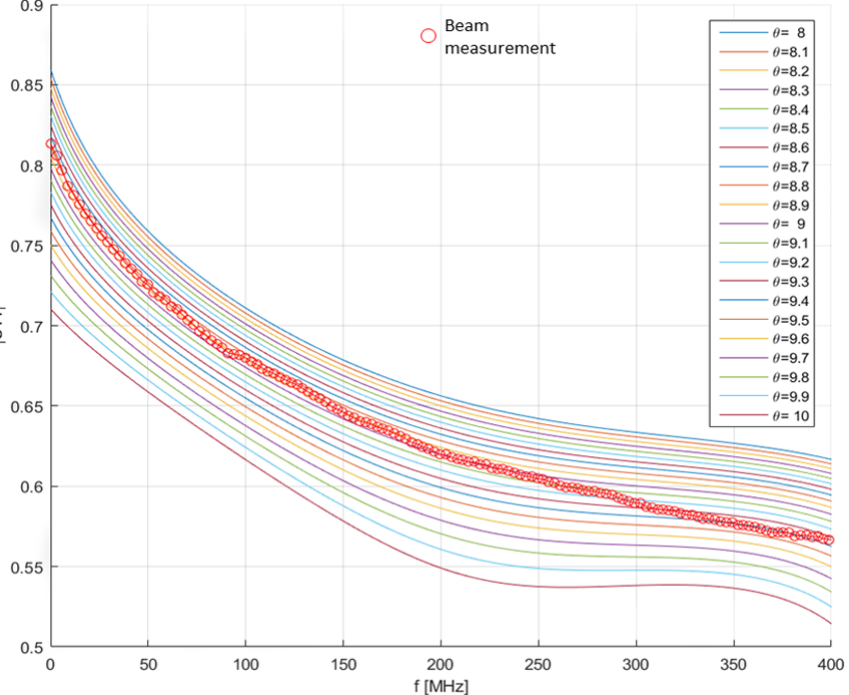
Figure 10. Comparison of the measured | S 11 ( f ) | (curve with red circles) and the iso- θ curves obtained from Θ